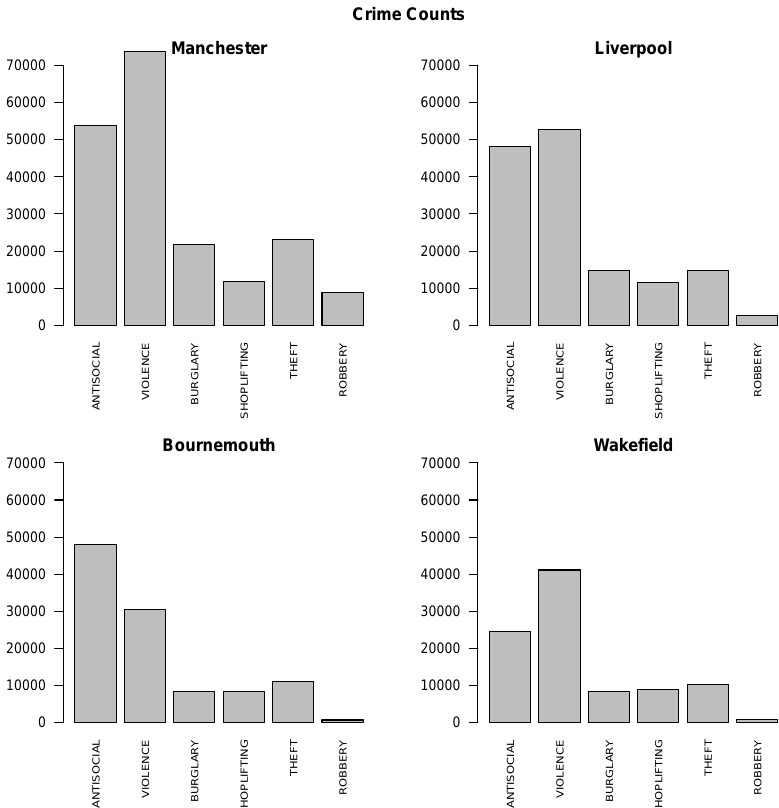
Figure 1. Crime counts for each crime type within each urban area.